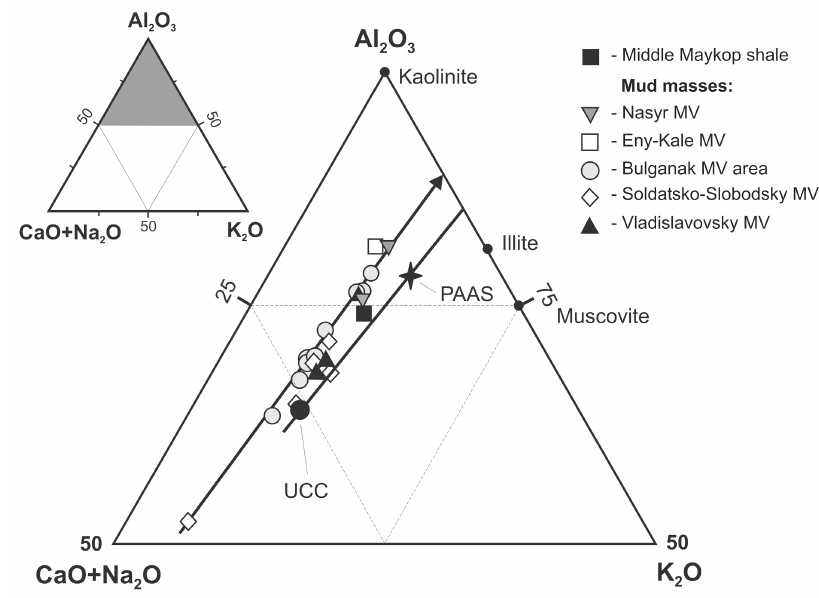
Figure 5. Chemical weathering ternary after [75].